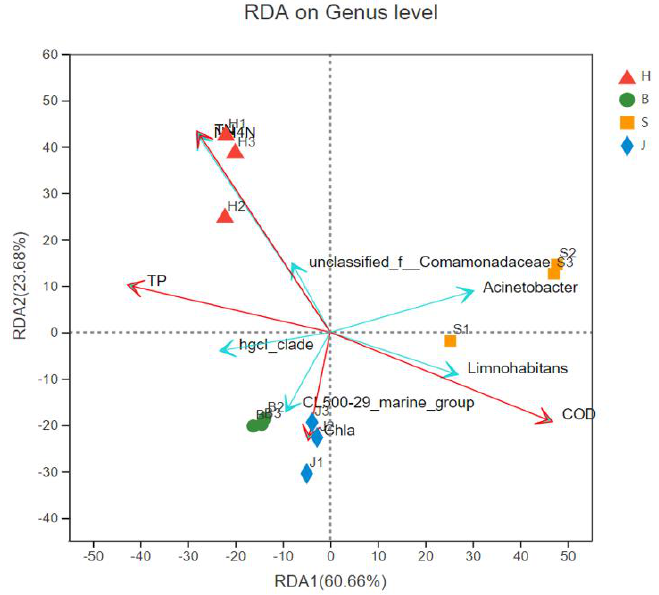
Figure 9. Correlation analysis between community structure and environmental factors. (H represents the Hechuan District, S represents the Shapingba District, J represents the Jiangbei District, and B represents the Beibei District. The longer the red arrow, the greater its influence and the longer the blue arrow, the greater its abundance, COD represents chemical oxygen demand, NH 4 N represents ammonia nitrogen, and Chla represents chlorophyll A.).